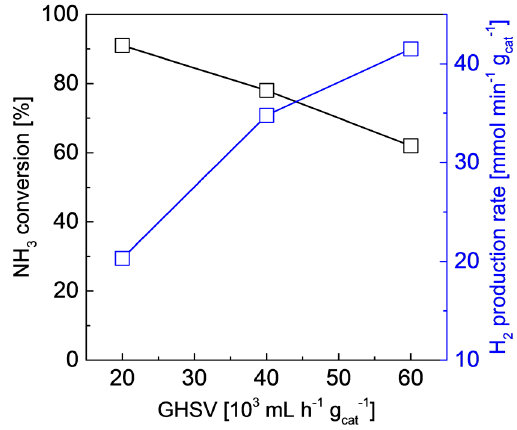
Figure 7. Catalytic performance of CS-60 Ru/graphene nanocomposites for ammonia decomposition at 450 °C under different GHSVs.